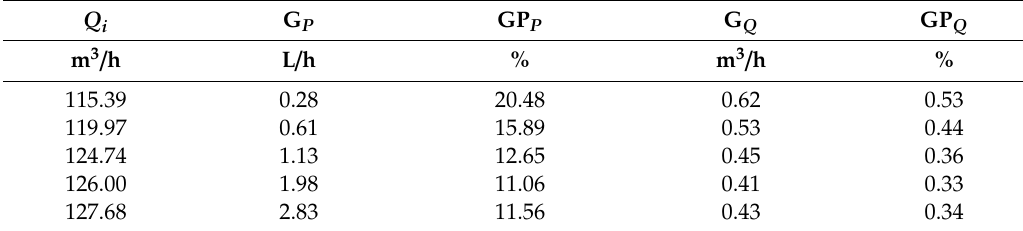
Figure 7. Average rain amount characteristics. ( a ) Affected by low ambient pressure; ( b ) Affected by inflow discharge. Table 3. Equivalent increase of average rain amount by decreasing ambient pressure and increasing inflow discharge.